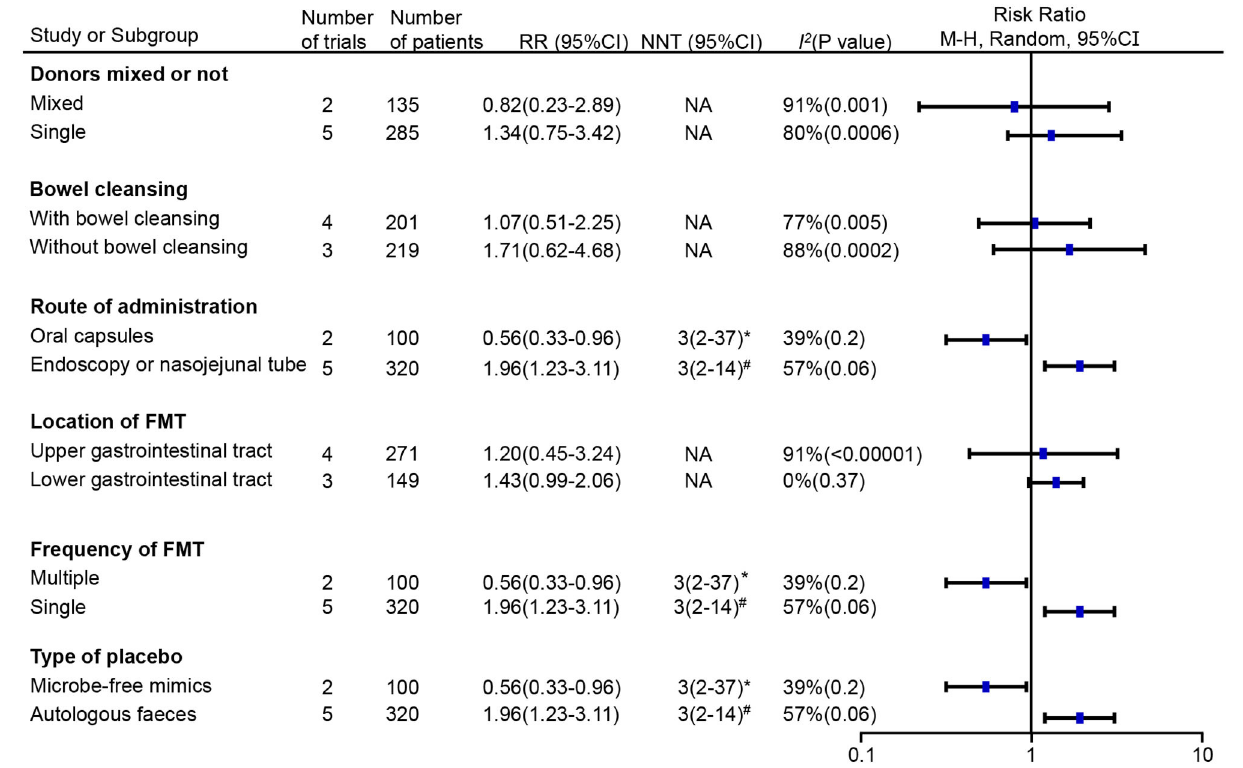
FIGURE 4 | Subgroup analyses of the effect of FMT on the primary outcome of irritable bowel syndrome (IBS) compared with placebo. RR, risk ratio; 95% CI, 95% confidence interval; NNT, number needed to treat; *number needed to harm (NNH); # number needed to treat (NNT); NA, not